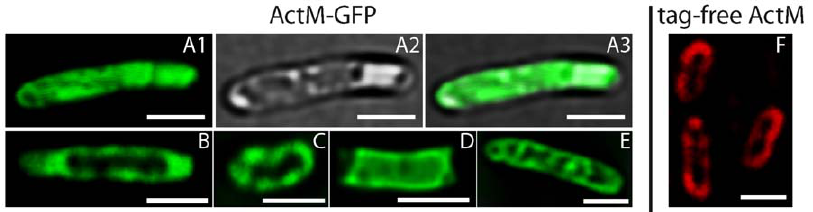
Figure 1. ActM-GFP expression in E.coli. ActM-GFP adopts a variety of shapes and apparently is not freely diffusible in E.coli . All images show the GFP-channel, except for A2 and A3 which display the transmission channel and an overlay of transmission and GFP, respectively. Image F shows anti- actin/TRITC immunofluorescence of untagged ActM expressed in E.coli . Scale bars: 2 m m.